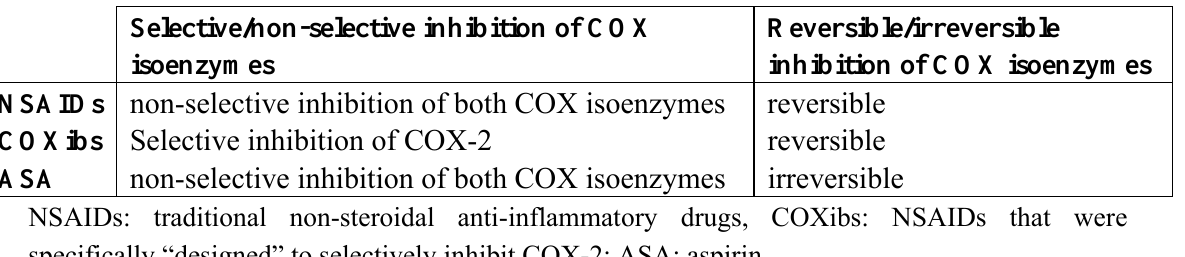
Table 1. Classification of NSAIDs according to the selectivity for COX enzymes and the type of COX inhibition